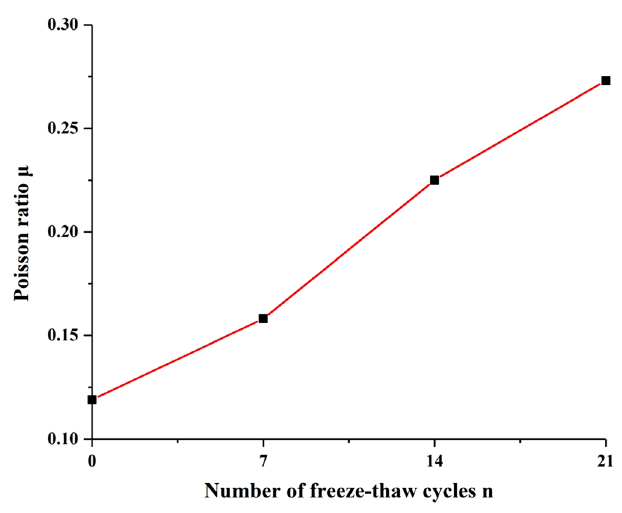
Figure 8. Poisson ratio of sandstone with different freeze–thaw